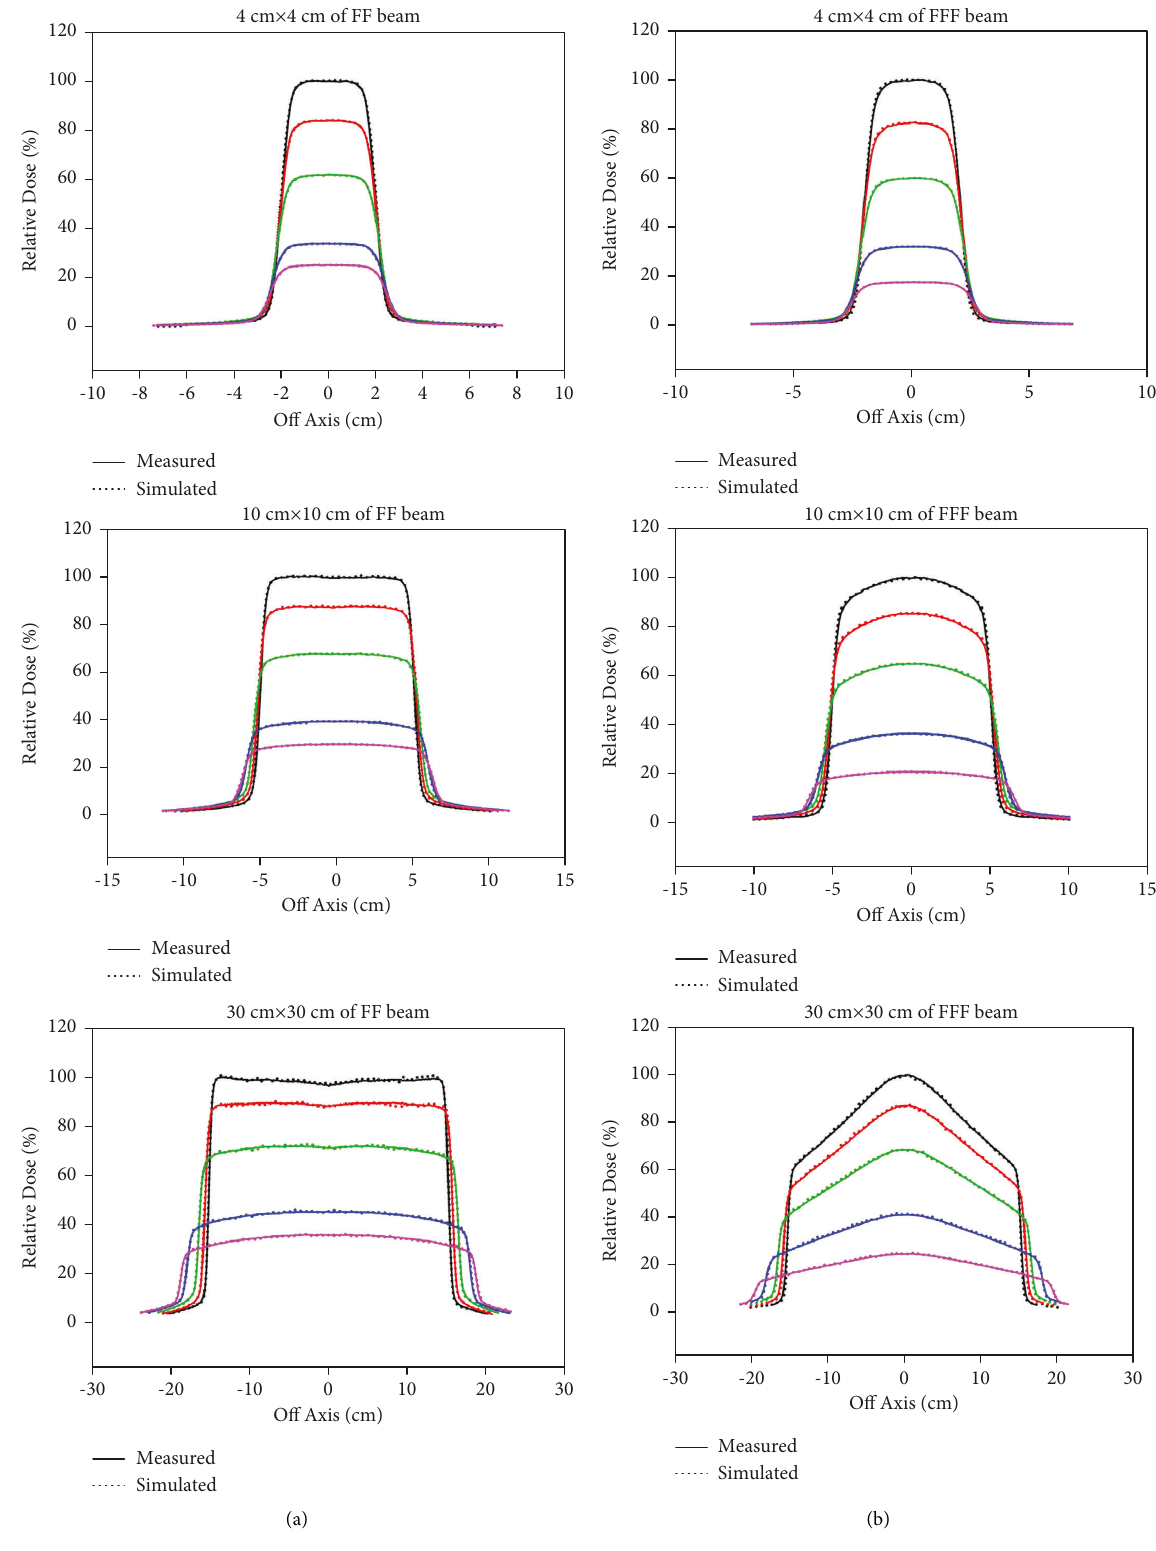
Figure 9: The comparison of measured and simulated off-axis dose curves for 4 × 4, 10 × 10, 30 × 30 cm 2 field sizes at various depths (the , 5, 10, 20, 25cm and the depths of FFF beams in (b) from top to bottom are, d depths of FF beams in (a) from top to bottom are, d max 10, 20, 30cm). Solid lines represent measured data and dotted lines represent simulated